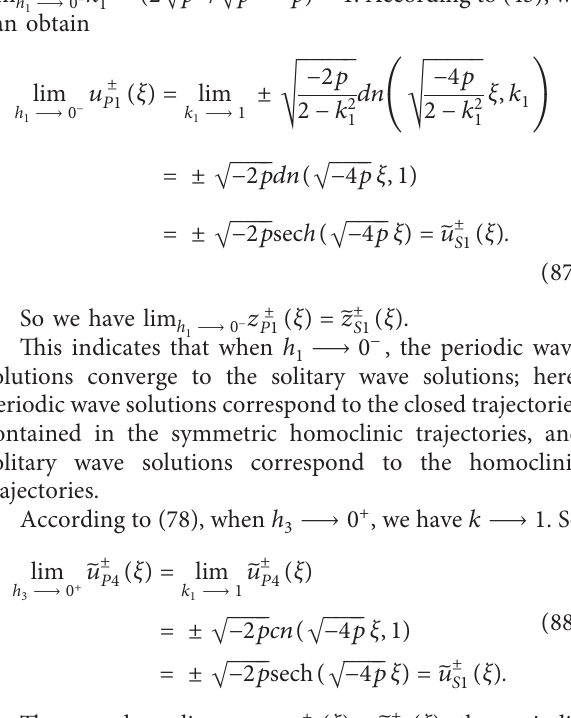
Figure 6: Diagram of − F Δ < 0 ,q <